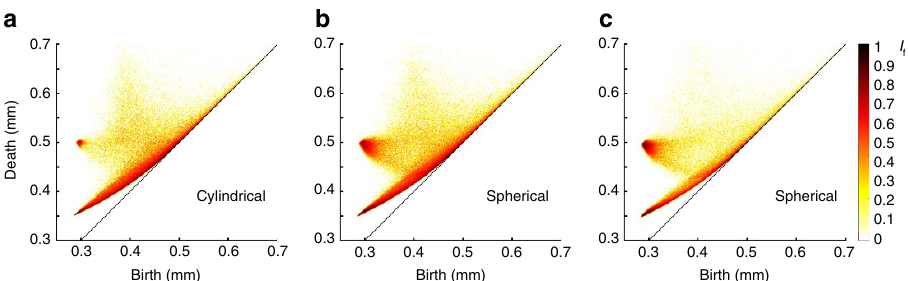
Figure 3 | Persistence diagram of experimental packings. Persistence diagrams PD 2 of partially crystallized packings produced in: ( a ) a cylindrical container with a density f ¼ 0.66 ( N ¼ 61,000 and D ¼ 1.62mm, note that the ( b,d ) coordinates have been rescaled to be directly comparable with data shown in panels ( b , c ) for which D ¼ 1mm), ( b ) a spherical container with a density f ¼ 0.685 ( N ¼ 86,000 and D ¼ 1mm), ( c ) a spherical container with